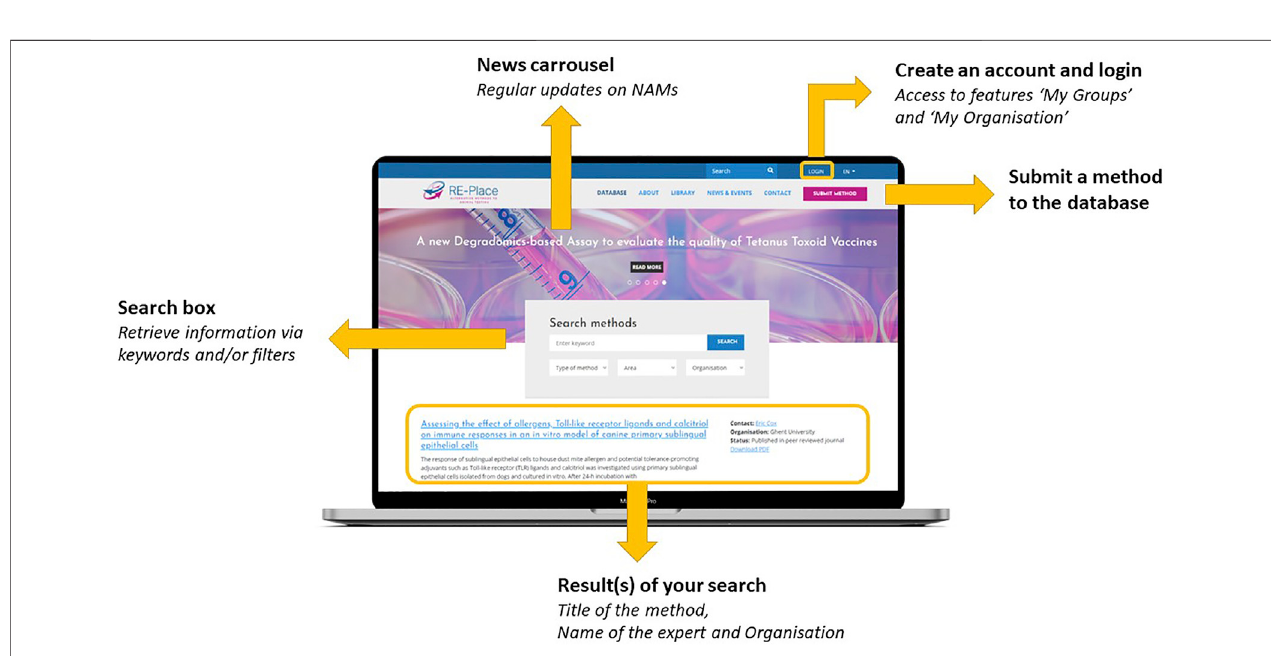
FIGURE 1 | The RE-Place online tool and more in particular, the second step in the submission process.